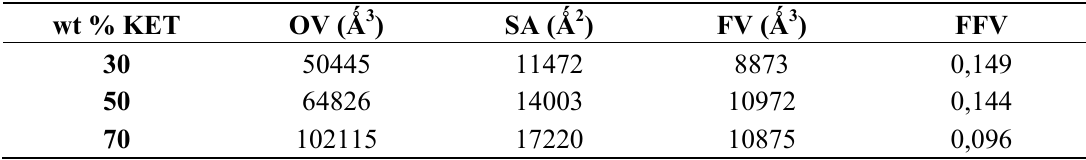
Table 4. The occupied volume (OV), the surface area (SA), the free volume (FV) and the fractional free volume (FFV), calculated by Atom Volumes & Surface Tool for the models PEBAX/KET at different compositions of